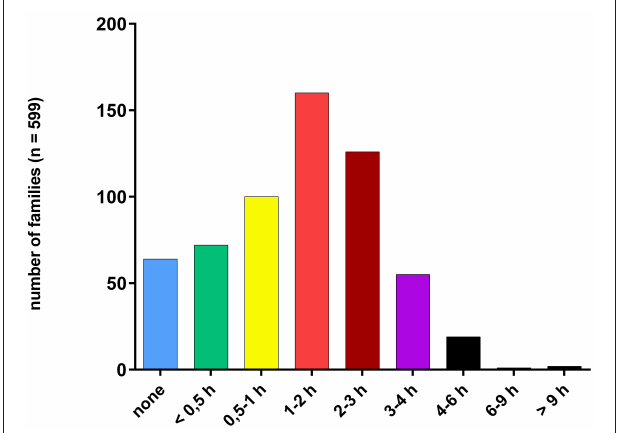
FIGURE 3 | Family TV time (in hours) on average